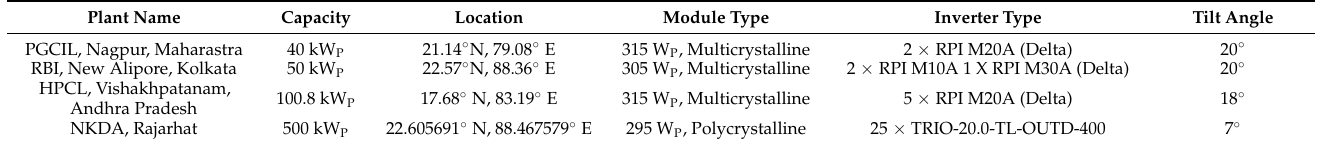
Table 1. Details of four SPV power plants.